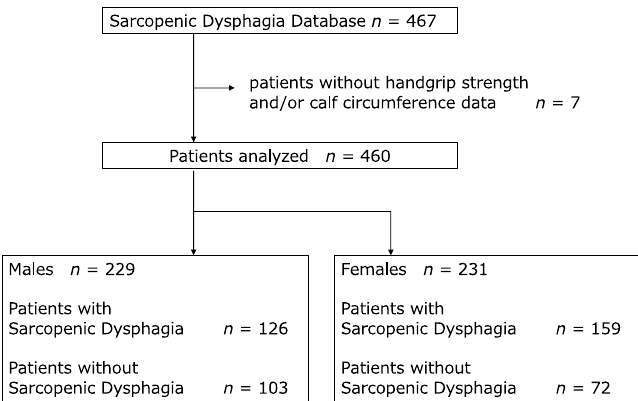
Figure 1. Flowchart of participants. Table 1. Patient Characteristics. ¶; χ 2 test, *; Mann–Whitney U test, §; unpaired t-test, SD: sarcopenic dysphagia, BMI: body mass index, HGS: handgrip strength, CC: calf circumference, CCI: Charlson